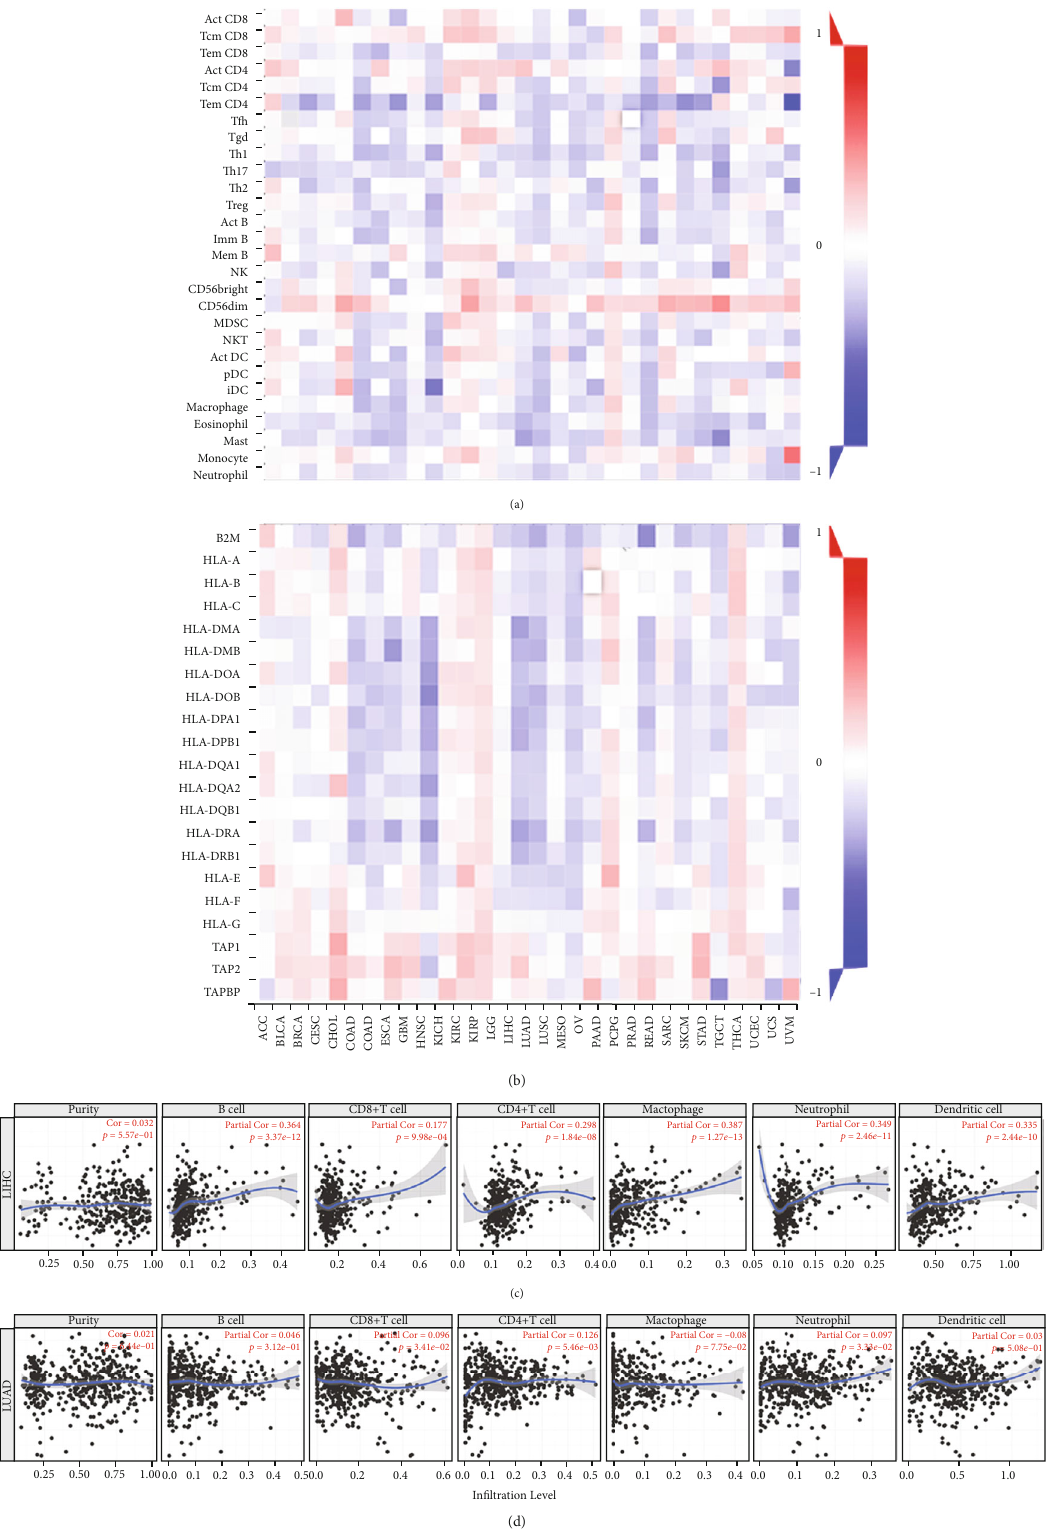
Figure 5: Correlations between DHX37 expression and TILs across human cancers. (a, b) Heat map showing relations between expression of DHX37 and 28 types of TILs as well as 21 types of MHC molecules. (c) DHX37 expression level has signi fi cant positive correlations with in fi ltrating levels of CD8+ T cells, CD4+ T cells, macrophages, neutrophils, B cells, and DCs in LIHC. (d) DHX37 expression level has signi fi cant positive correlations with in fi ltrating levels of CD4+ T cells and neutrophils and negative correlations with CD8+ T cells in LUAD. P < 0 : 05 is considered signi fi